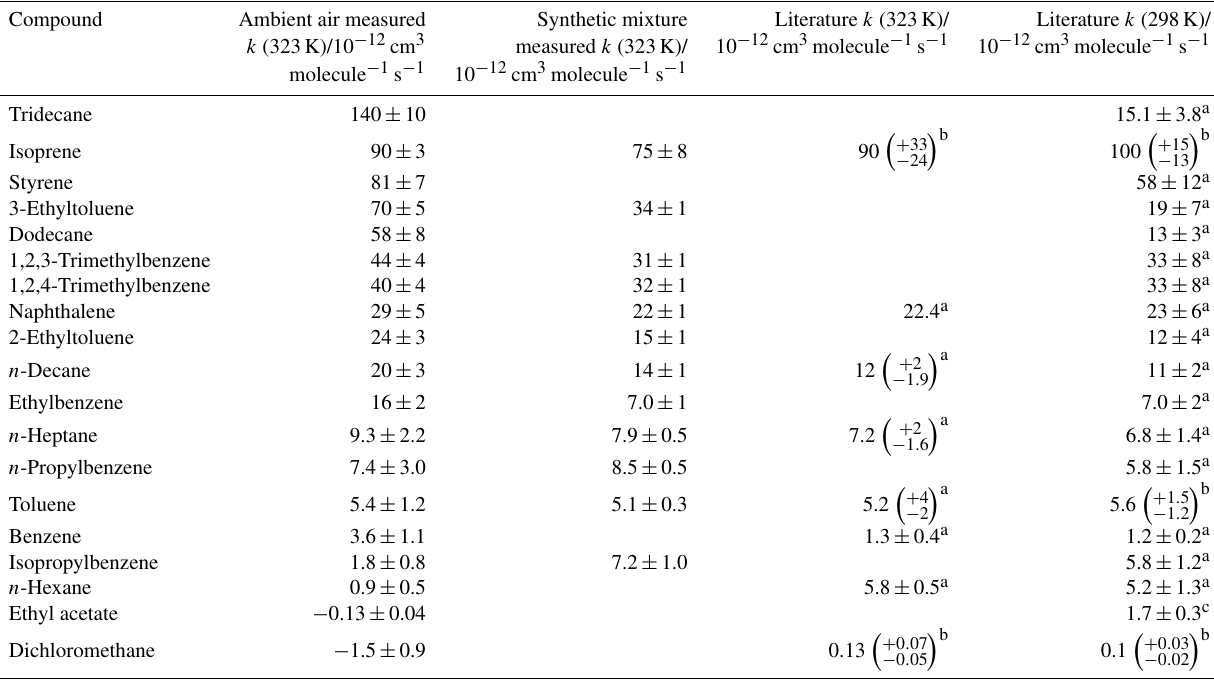
Table 4. Results of relative rate experiments, with literature data, for VOCs in the ambient air analysis, ordered by ambient air measured k